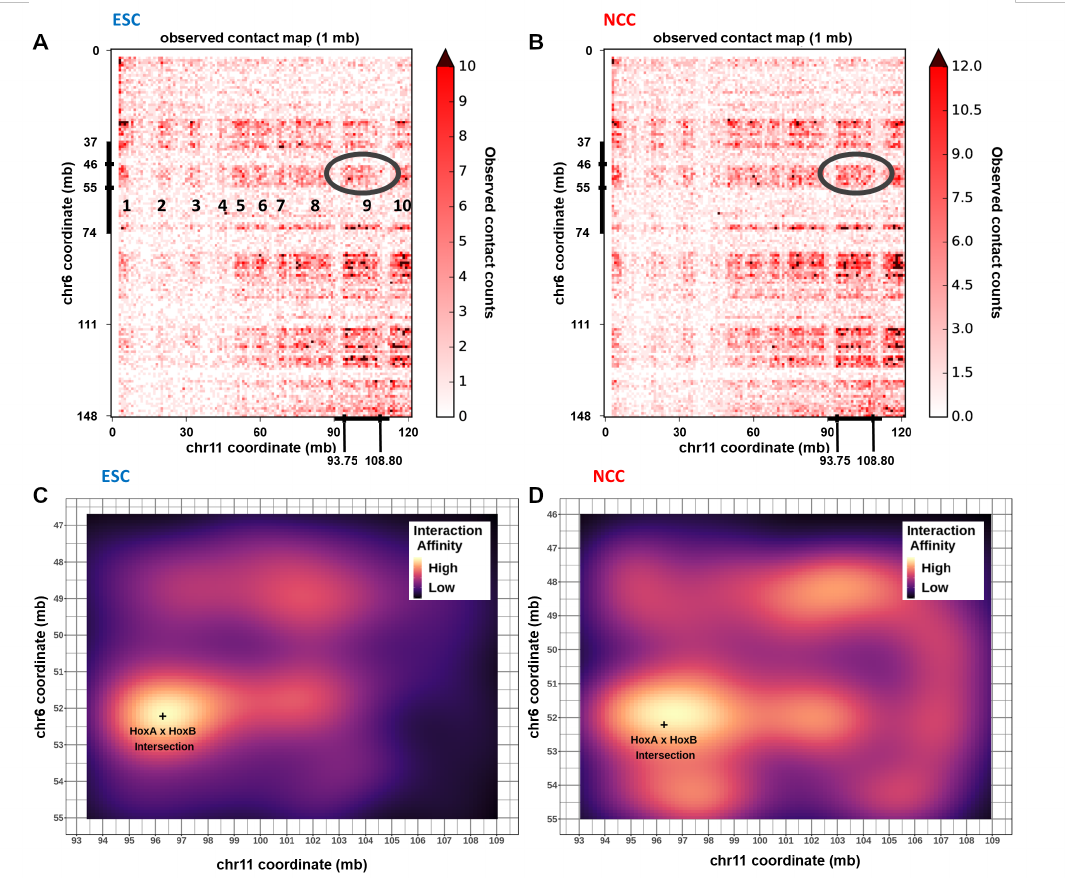
Figure 8. HoxA and HoxB clusters connect interchromosomally and reorganize during NCC differentiation. ( A , B ) Interchro- mosomal contact map showing locations enriched for interactions between Chr6 and Chr11 (1–10 examples numbered) with the HoxA-B interaction block circled. ( C , D ) Interchromosomal contact map showing enhanced view of HoxA-B interaction block with (+) indicating the intersection between the HoxA and HoxB cluster